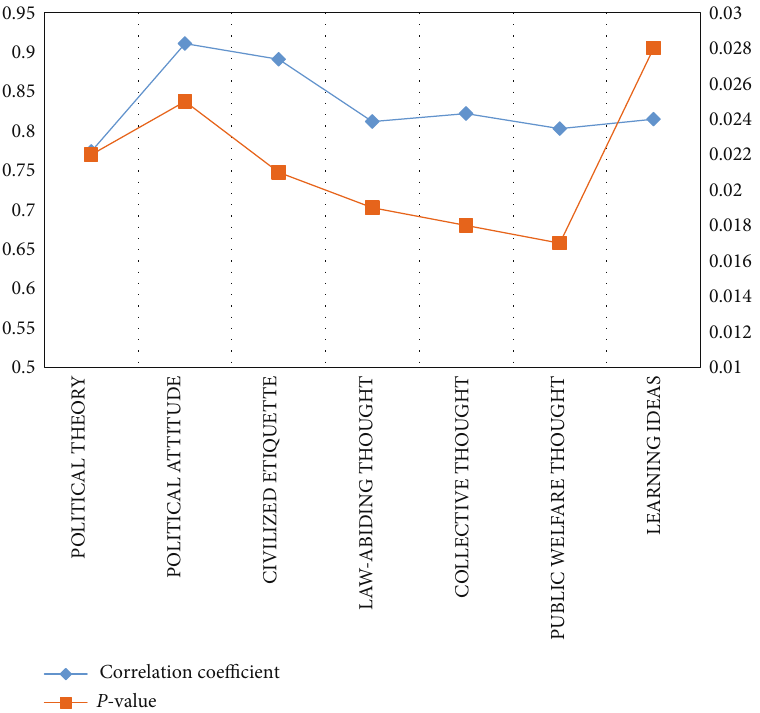
Figure 7: Correlation analysis between indicators and students ’ quality view.